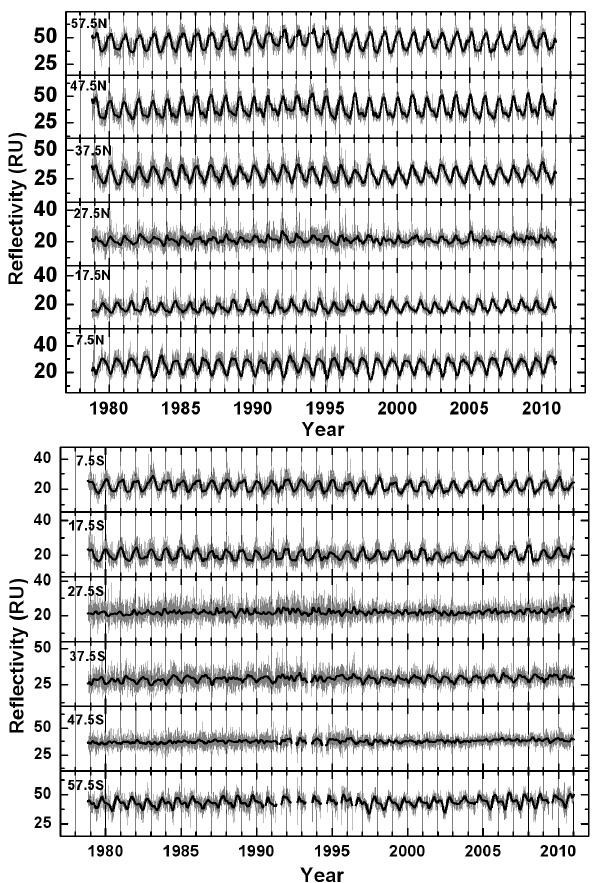
Fig. 3. LER zonal average time series for twelve 5 ◦ bands from 57.5 ◦ S to 57.5 ◦ N (1979–2010). The light grey color corresponds to daily LER, while the black solid lines are a 30-day low-pass filter of the daily data.